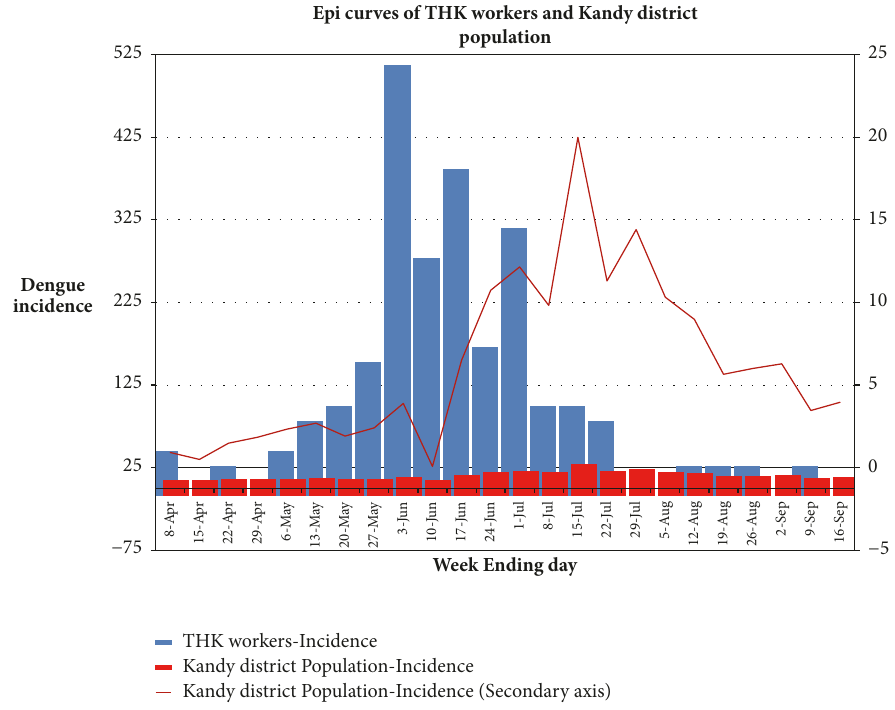
Figure 1: The epicurve. This shows the temporal sequence of weekly dengue incidences of the THK workers (blue bars) and the Kandy district population (red bars) and the weekly change in dengue incidence among the Kandy district population (red line). X-axis: the last day of the each week. Primary Y-axis: weekly dengue incidences (per 100000 population). Pattern of temporal changes of Kandy district population is not obvious here. Secondary Y-axis more clearly illustrates the pattern of temporal changes of the weekly dengue incidences of the Kandy district population in a different scale (red